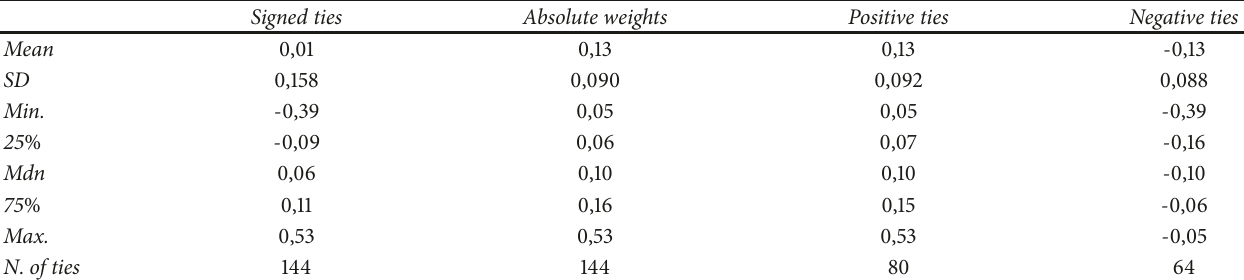
Table 2: Description of ties in partial correlation